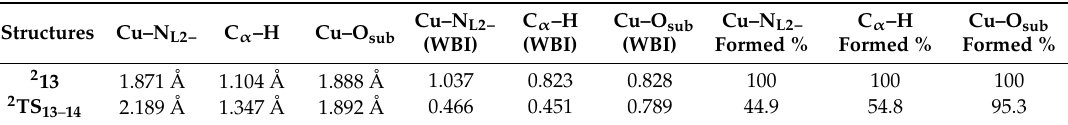
Table 1. Distances and Wiberg Bond Index (WBI) for Cu–N L2– , C α –H and Cu–O sub for 2 13 and 2 TS